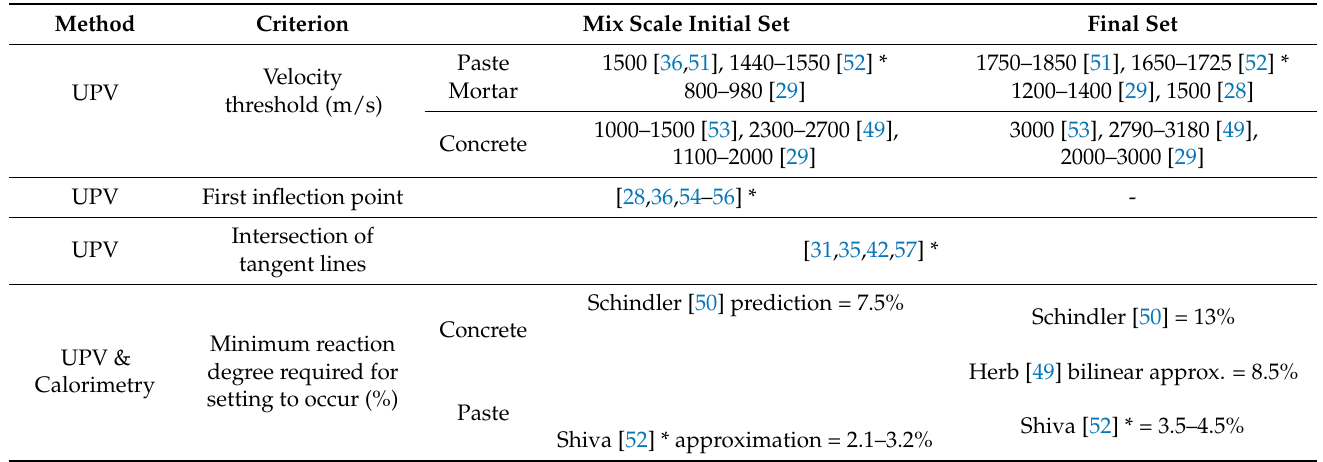
Table 1. Initial and final setting estimation by different evaluation techniques for OPC systems and AAMs.